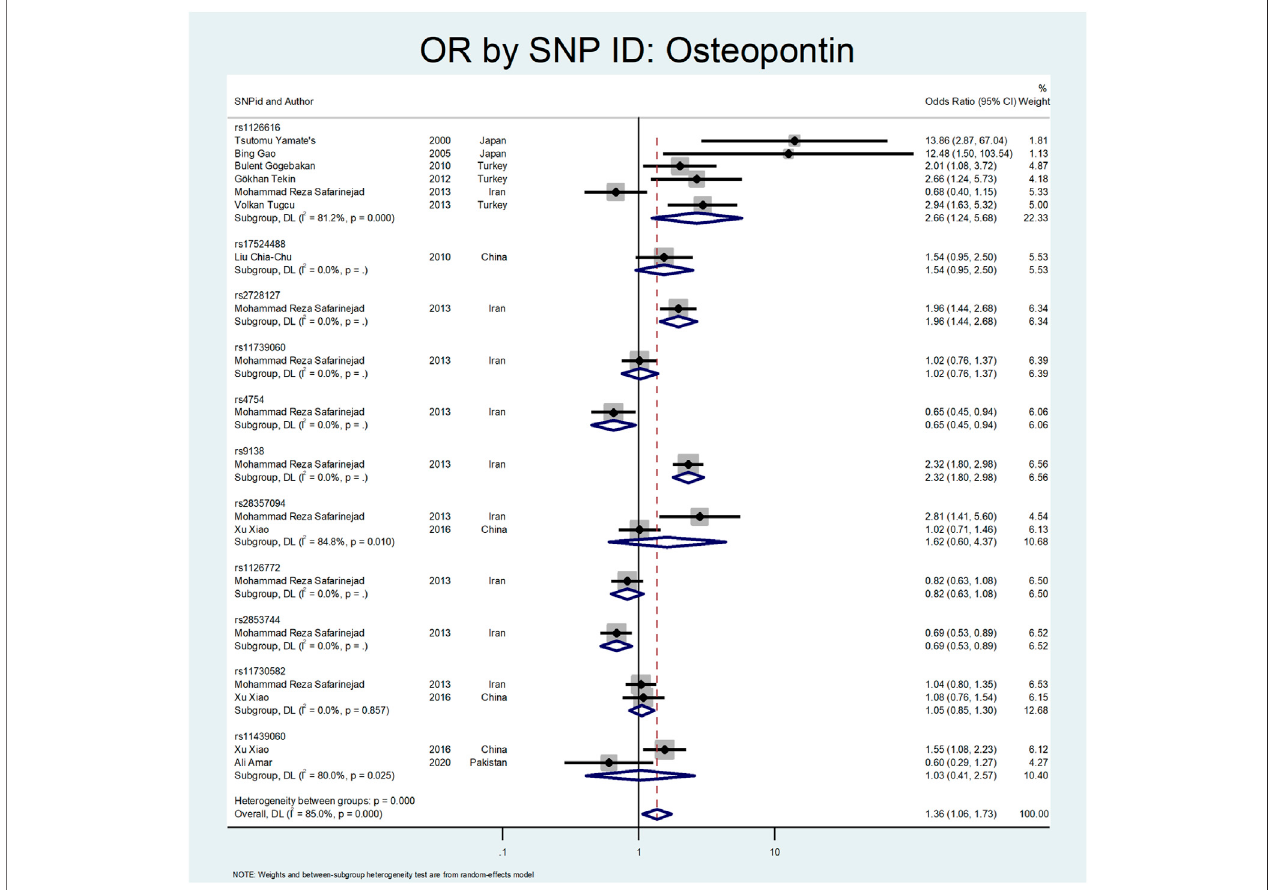
FIGURE 11 | Subgroup analysis for Osteopontin, by SNP subgroup.